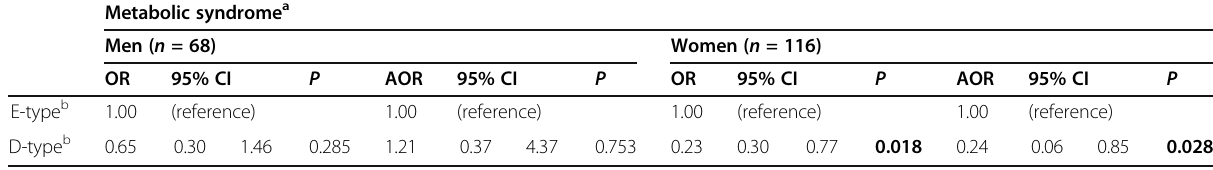
Boldface indicates statistically significant differences OR odds ratio, AOR adjusted odds ratio by age, CI confidence interval a The dependent variables are defined by “ the presence of metabolic syndrome or pre-metabolic syndrome: case ” and “ non-metabolic syndrome: non-case ” b The independent variable is the type of physical activity. D-type and E-type: see Table 1